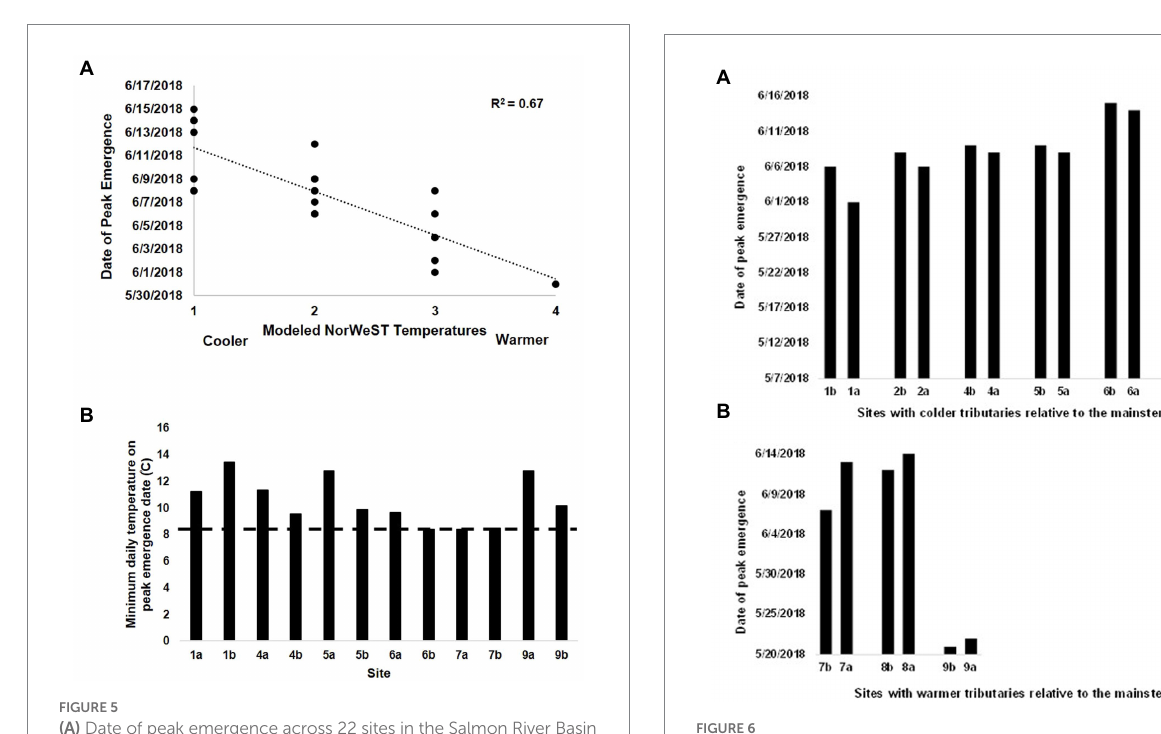
FIGURE 6 Comparison of timing of salmonfly emergence at paired reaches in the Salmon River basin [sites (1–8) and Henry’s Fork of the Snake River (sites 9 and 10)] located above and below confluences (a and b, respectively), Idaho, United States in June 2018. Thermal discontinuities created by tributary confluences were associated with temporal asynchrony in emergence timing (binomial test p = 0.002; a = above, b = below confluence). (A) Sites with colder tributaries relative to the mainstem. Emergence occurred above the confluence first then below. (B) Sites with warmer tributaries relative to the mainstem. Emergence occurred below the confluence first, then above. Temperature is based on measurements taken within a few days of peak emergence. Site 3 was excluded for this comparison due to lack of sufficient temperature data required to assess whether the waters above or below the confluence were warmer on the date of peak emergence.